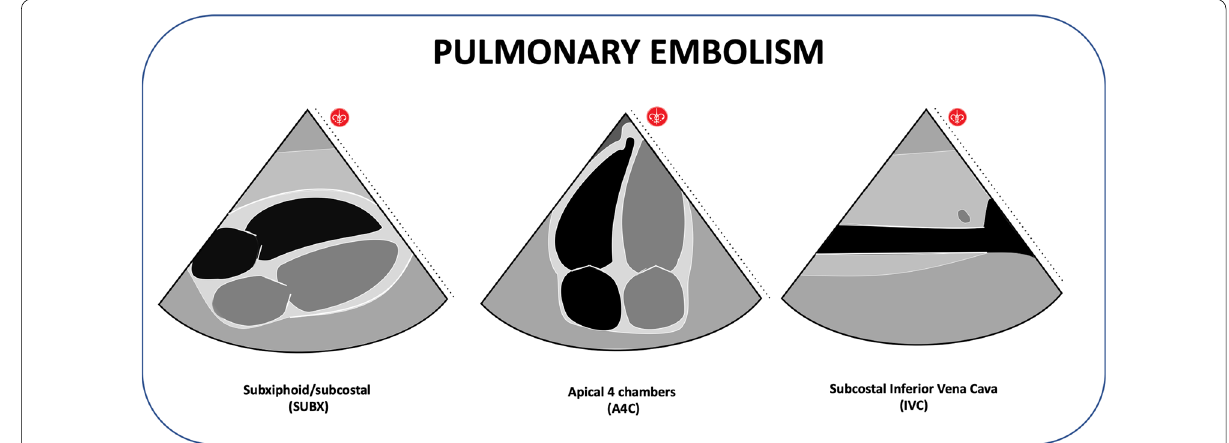
Fig. 5 Pulmonary embolism